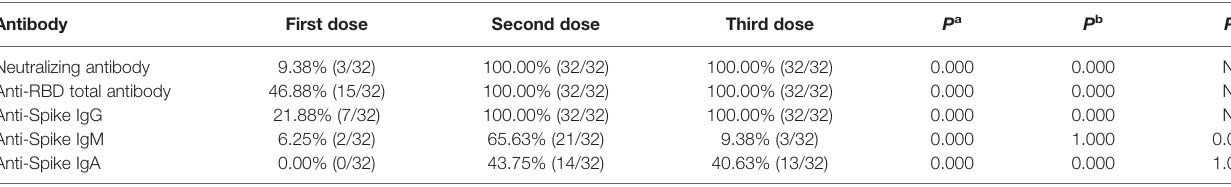
a Difference between the fi rst dose and second dose. b Difference between the fi rst dose and third dose. c Difference between the second dose and third dose. NA,notapplicable.Fisher ’ sexacttestwasusedtoanalysesforthepositiveconversionratebetweentheseconddoseandthirddose.However,thetestcouldnotbeperformedduetothe number of rows and columns of the crosstab being less than two.